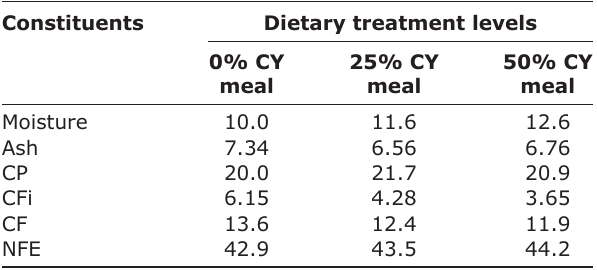
Table-2: Proximate nutritional constituents of the three dietary treatments in varying amounts of cocoyam meal as partial energy replacement for maize.